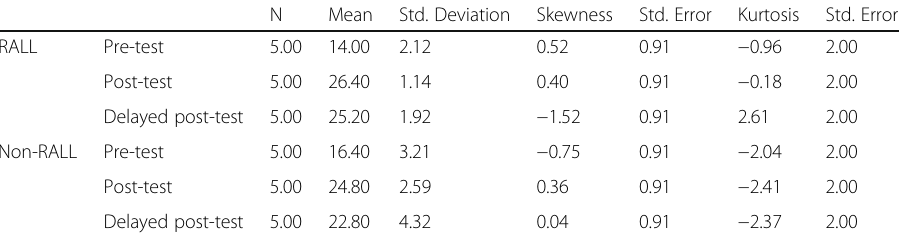
Table 3 Descriptive Statistics of RALL and non-RALL Groups in Different Times of Testing N Mean Std. Deviation Skewness Std. Error Kurtosis Std. Error RALL Pre-test